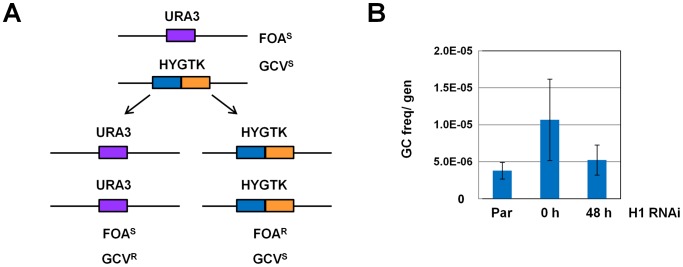
Histone H1 depletion does not affect recombination frequency at the Pol II-transcribed URA3 locus.
A. The experimental assay for gene conversion is as described in [60], [61]. One allele of the URA3 gene (violet box) is replaced by a hygromycin resistance/thymidine kinase fusion gene (HYGTK) (blue and orange boxes). Gene conversion at this locus either results in cells which have two copies of the URA3 gene and are sensitive to FOA (FOAS) and resistant to ganciclovir (GCVR). Alternatively, the cells have two copies of the HYGTK gene and are FOA resistant (FOAR) and sensitive to ganciclovir (GCVS). B. Frequency of gene conversion at the URA3 locus in parental (Par) cells or those containing the histone H1 RNAi construct. Cells were removed from hygromycin selection for 48 hours, and one culture of H1 RNAi cells had histone H1 RNAi induced for 48 hours. Cells were then plated in the presence of either GCV or FOA and the number of positive wells were scored after eight days. The value shown is the sum frequency of FOAR and GCVR clones, which can be considered to have undergone gene conversion (GC), divided by the number of generations undergone by each cell line. Bars show the mean of three independent experiments with standard deviation indicated with error bars. The differences between the samples were not statistically significant.